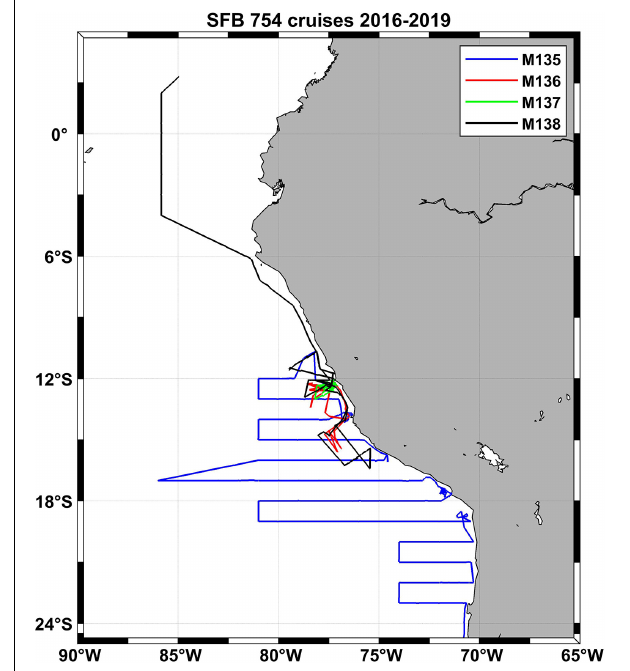
FIGURE 7 | Cruise tracks of four SFB 754 cruises in the Pacific in the third funding period of the project (2016–2019).